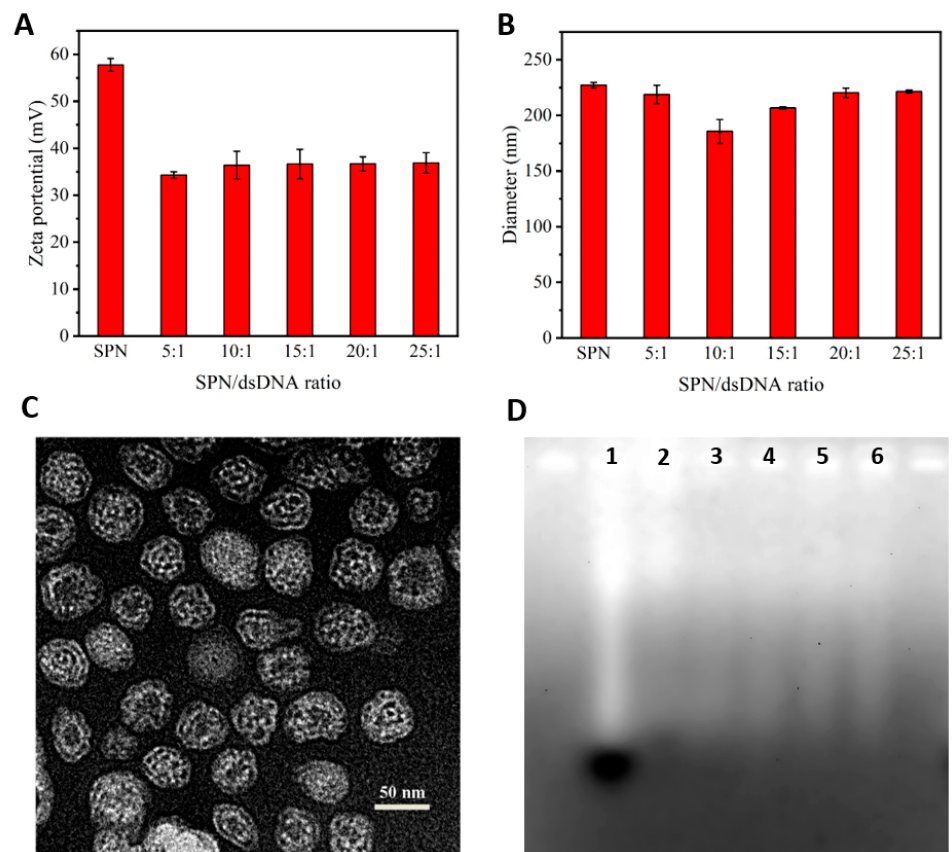
Figure 4. Characterization of SPN. ( A ) Hydrodynamic diameter and ( B ) zeta potential of SPN and SPN/DNA complexes measured by DLS. Data represent mean ± SD (n = 3). ( C ) TEM images of SPN. Scale bar, 50 nm. ( D ) Gel retardation assay for the detection of the loading of DNA probe to SPN. Lane 1, free dsDNA as control; lanes 2 − 6, SPN/DNA complexes prepared at weight ratios (SPN/DNA, w/w) of 2.5, 5, 10, 15 and 20, respectively.